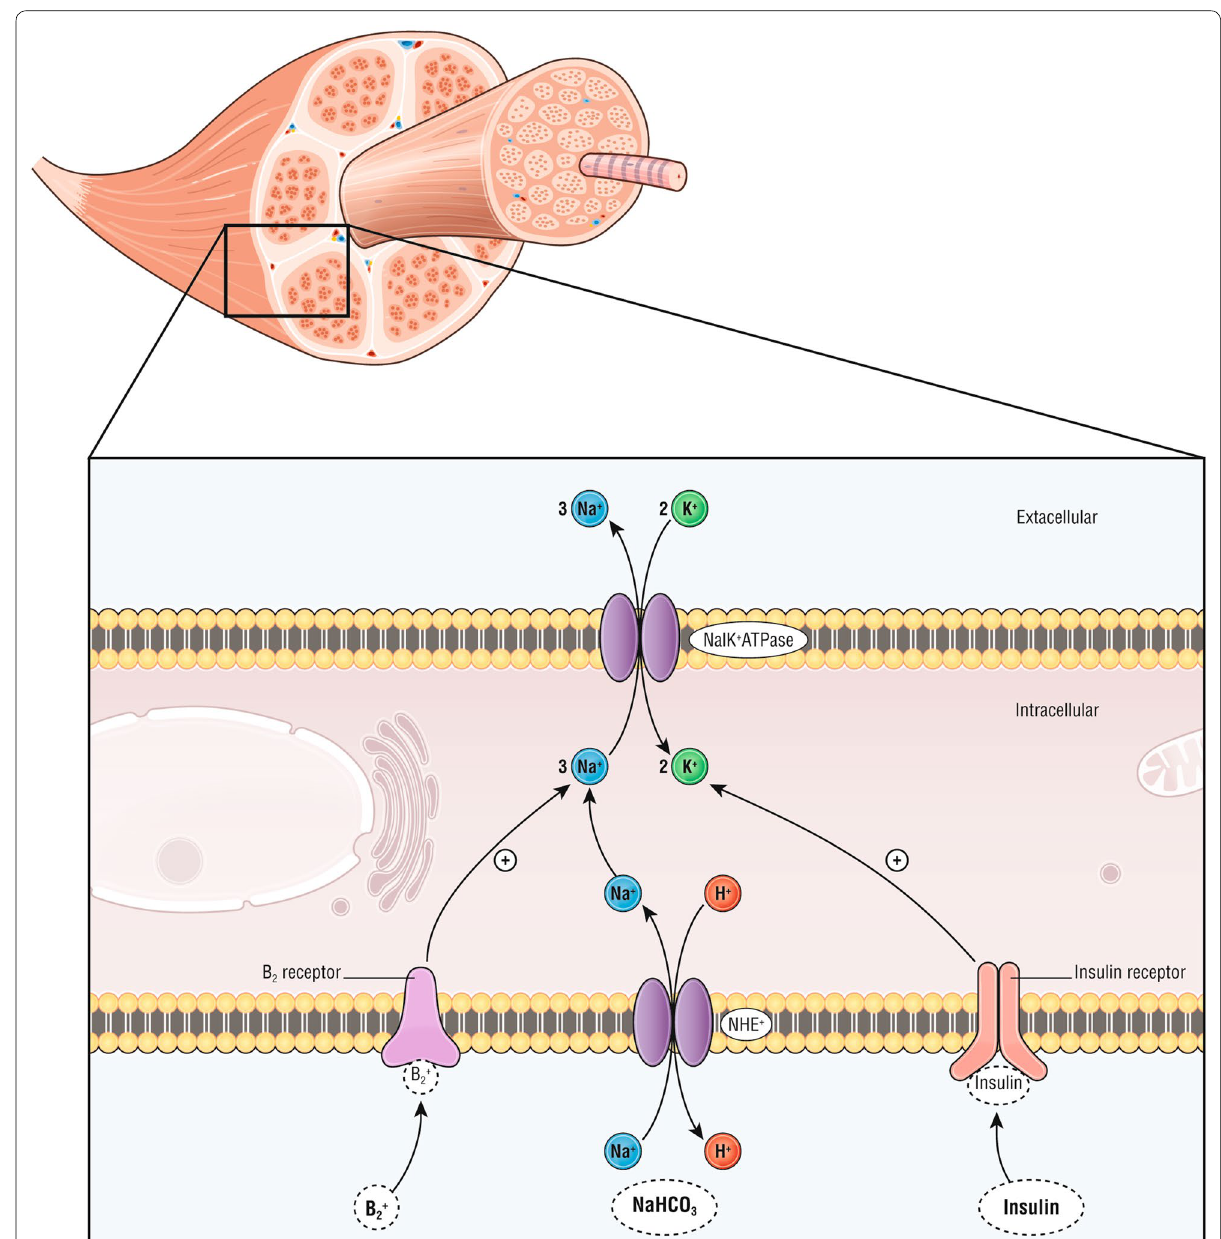
Fig. 3 Action mechanisms of plasma lowering treatments by intracellular transfer. β-2 agonist (i.e., salbutamol) binds the β-2 receptor, insulin binds insulin receptors and sodium bicarbonate (NaHCO 3 ) induces an intracellular entrance of sodium through the Na + /H + exchanger (NHE), all activate the sodium–potassium adenosine triphosphatase (NaK + ATPase) leading to a potassium transfer from the extracellular space to the